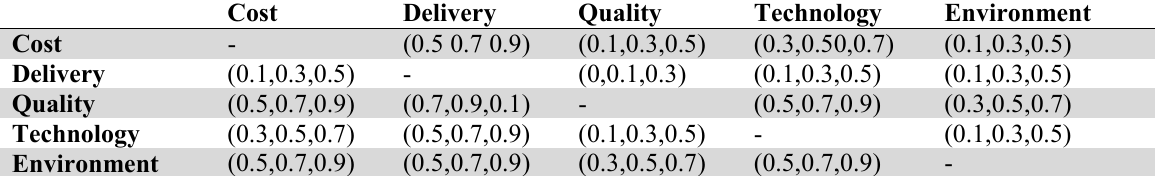
Comparison of the relative importance of the main criteria for selecting the supplier